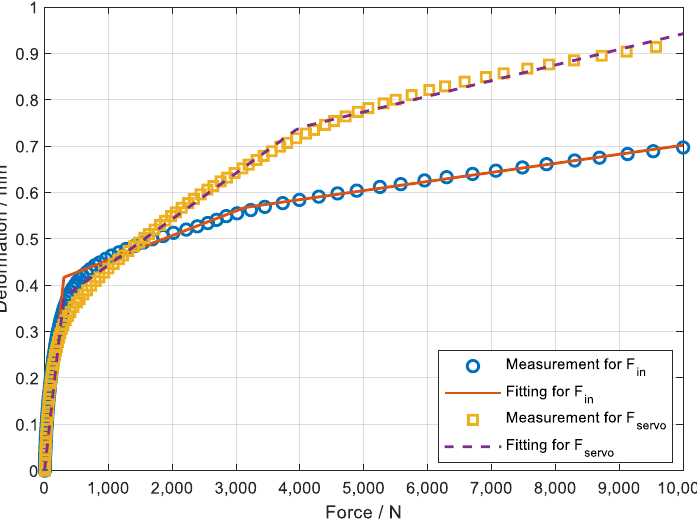
Figure 8. Piecewise fitting for quasi-static behavior. The dynamic behavior is fitted by a second-order transfer function with two poles and one zero. The normalized transfer function is described in Figure 9.